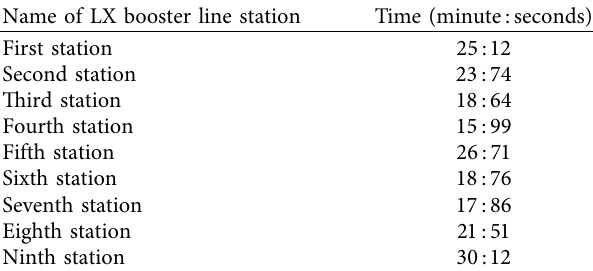
Table 6: LX booster line. Name of LX booster line station